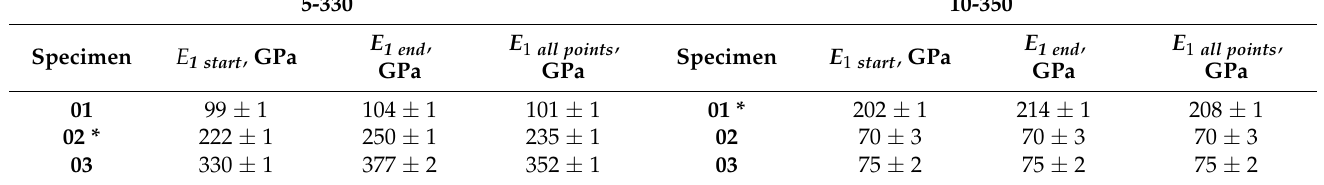
* A single mid-plane delamination was observed visually on the specimen surface during